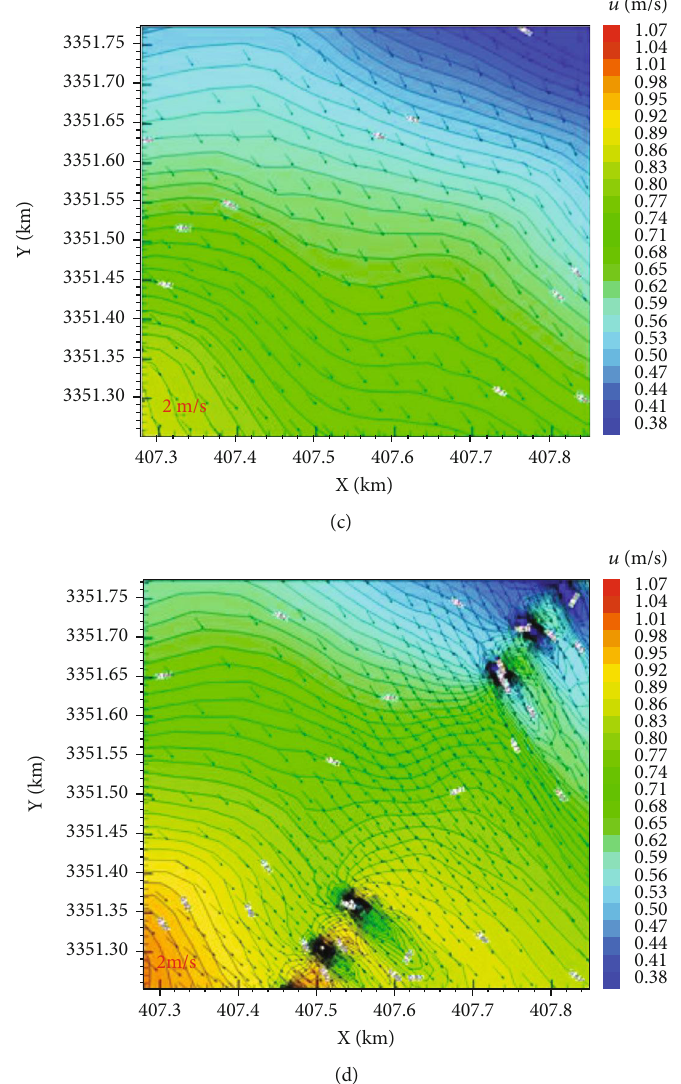
Figure 10: Comparison of fl ow fi eld distributions before and after the construction of the project (direction of the ebb tide is positive, and u indicates the fl ow velocity). (a, b) Rapid rise of spring tide. (c, d) Rapid fall of spring